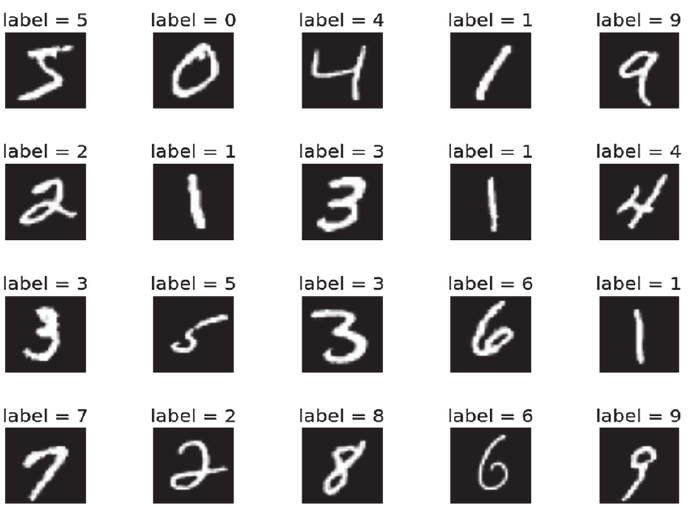
Figure 4. Sample images of the MNIST dataset. The MNIST dataset [23] is a large database of handwritten digits that is commonly used for training machine learning models, and it is composed of black and white images containing simple patterns.